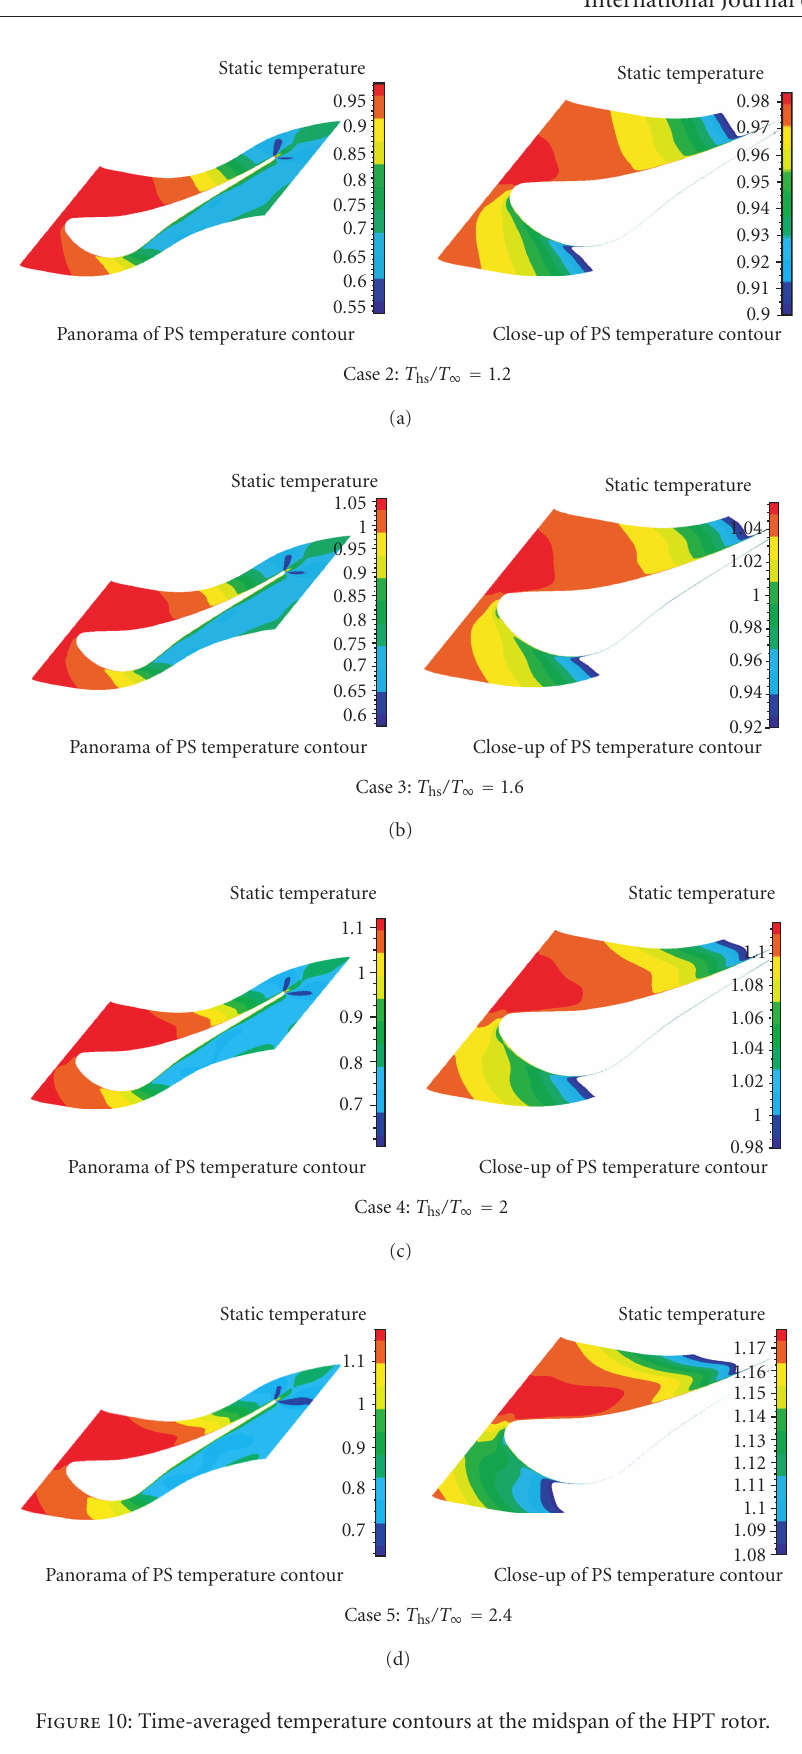
Figure 10: Time-averaged temperature contours at the midspan of the HPT